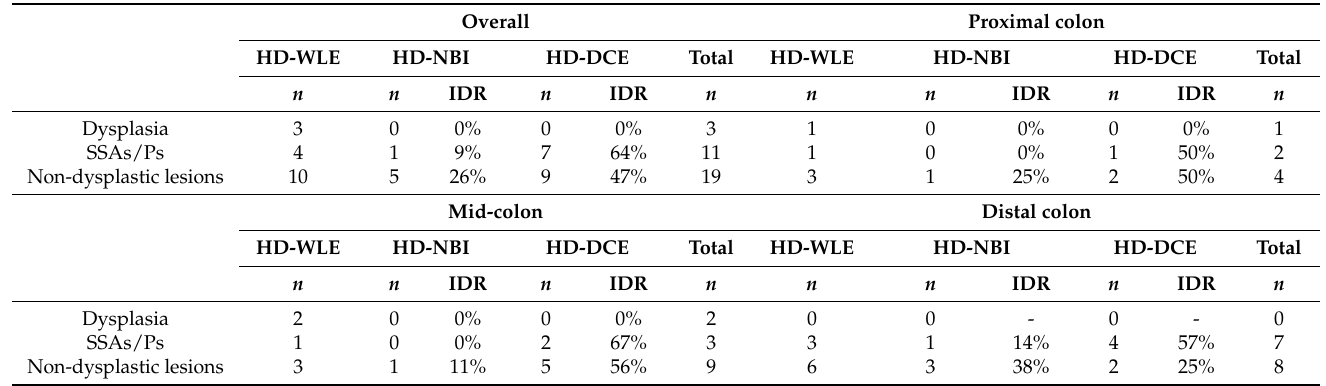
Table 4. Per-patient analysis of dysplasia, sessile serrated adenoma/polyps, and non-dysplastic lesions detected by HD-WLE, HD-NBI, and HD-DCE.